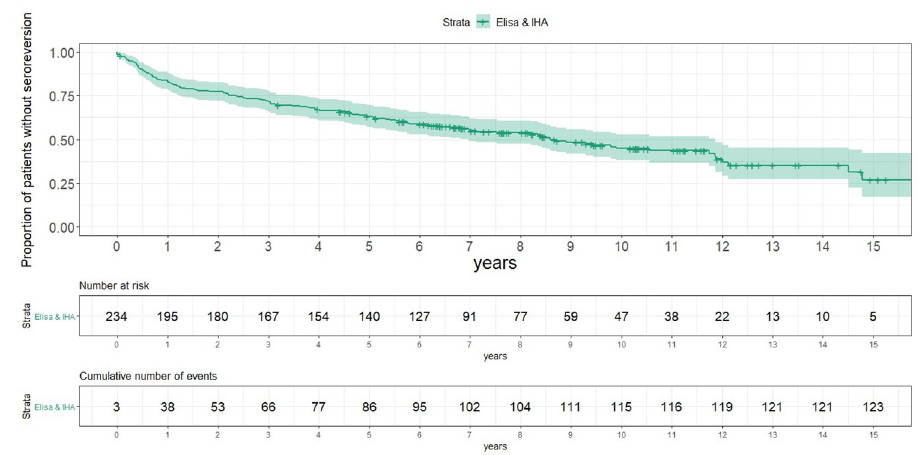
Fig 2. Serological seroconversion by ELISA and IHA profile in 234 treated patients (Kaplan-Meier).